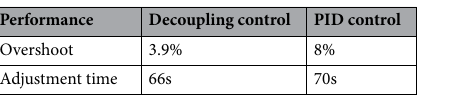
Table 2. Tracking performance.